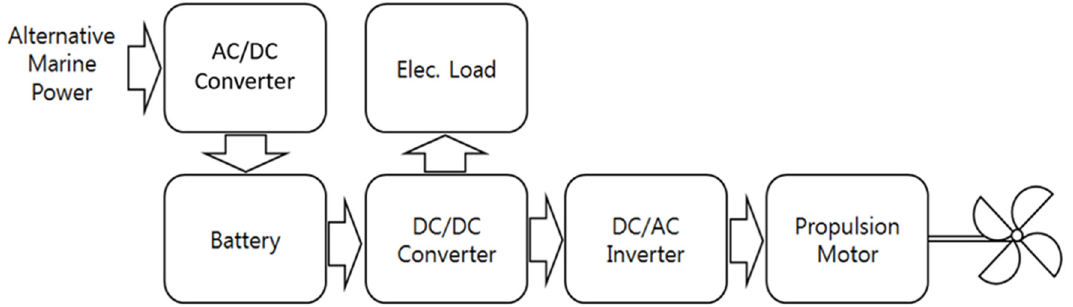
Figure 5. Electrical propulsion system (battery) schematic.